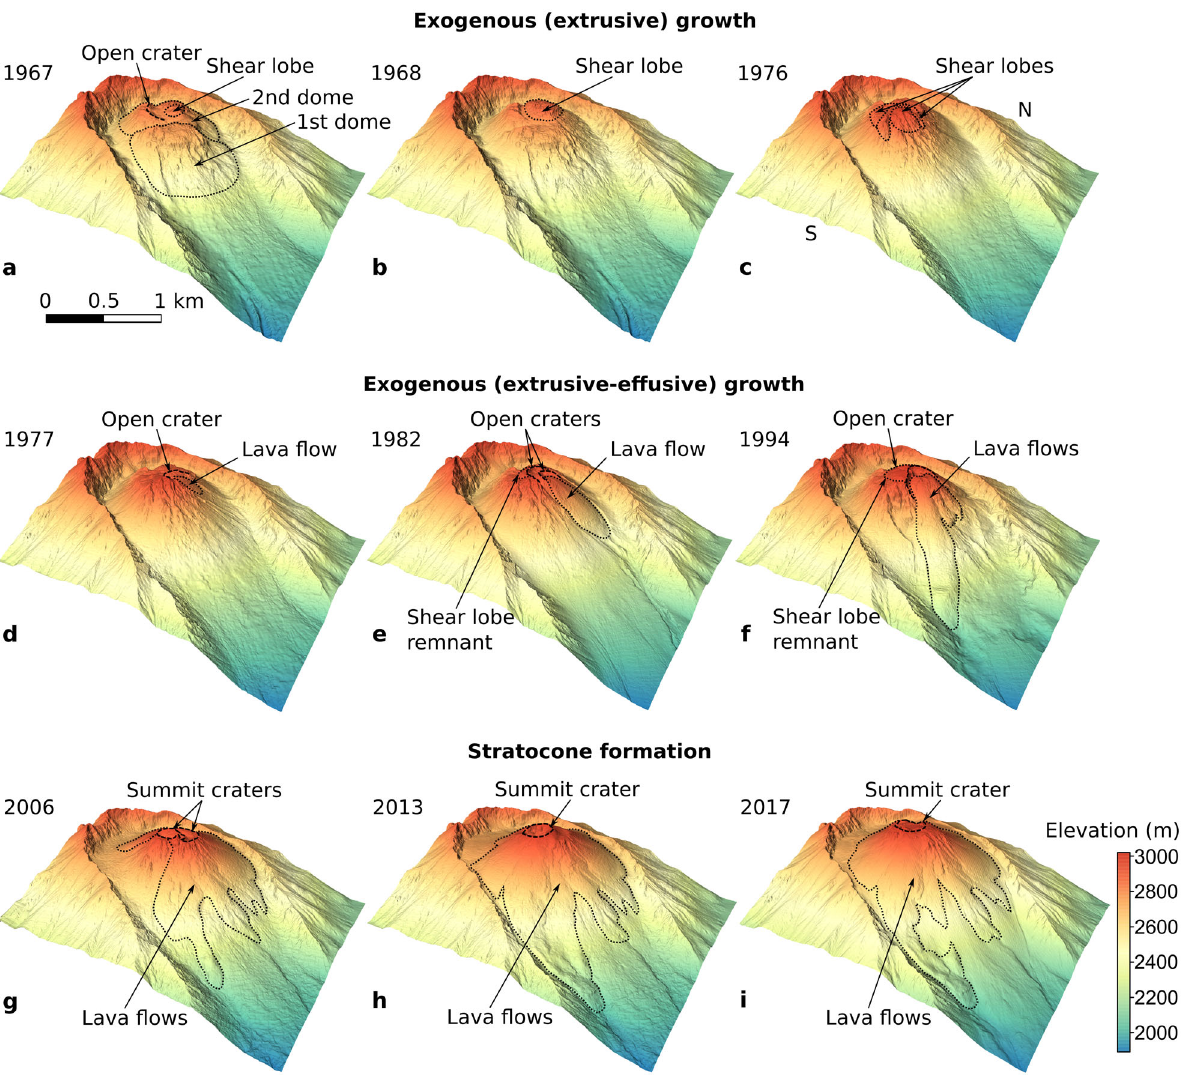
Fig. 2 Gradual re fi lling of the collapse amphitheater and edi fi ce evolution at Bezymianny between 1967 and 2017. Oblique (view from SSE) hillshade visualizations of DEMs of Bezymianny volcano at different stages of the post-collapse regrowth. a Transition from endogenous to exogenous dome growth. b , c Exogenous (extrusive) dome growth. d – f Exogenous (extrusive – effusive) dome growth. g – i Stratocone formation. Major structures are provided by dotted lines (domes, shear lobes, fl ows) and dashed lines (craters). DEMs were generated by photogrammetric processing of aerial and satellite